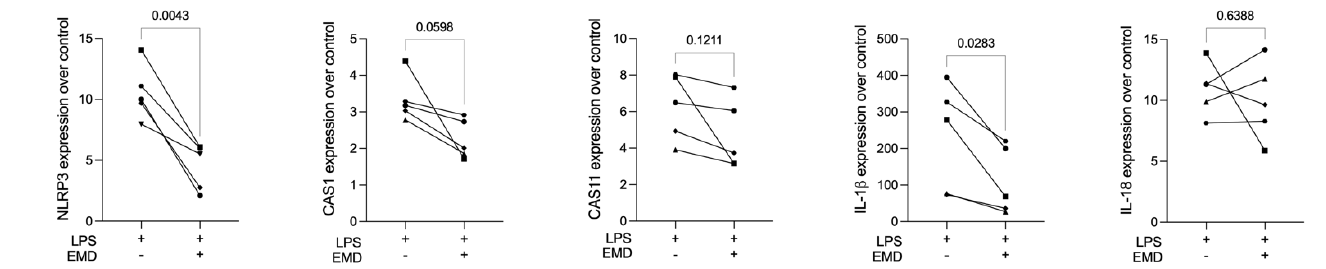
Figure 3. LPS stimulation caused an increase in the expression of the pyroptosis genes in RAW 264.7 macrophages. The application of EMD prior to LPS stimulation in RAW 264.7 cells led to a significant reduction in the forced expression of NLRP3 and IL-1 β , and a trend in the reduction of CAS1 and CAS11 gene expression. Different symbol shapes mean independent experiments. Paired t -test statistical analysis was applied to compare the groups.